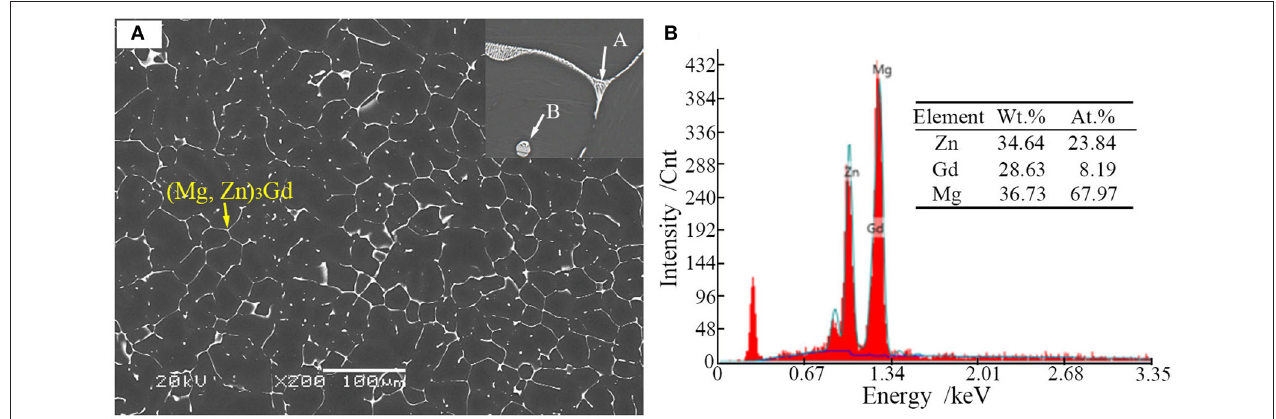
FIGURE 3 | (A) Scanning election microscopic image and enlarged image (onset) of the as-cast Mg-2.0Zn-0.5Zr-3.0Gd alloy; (B) EDS analysis results of the eutectic compounds.